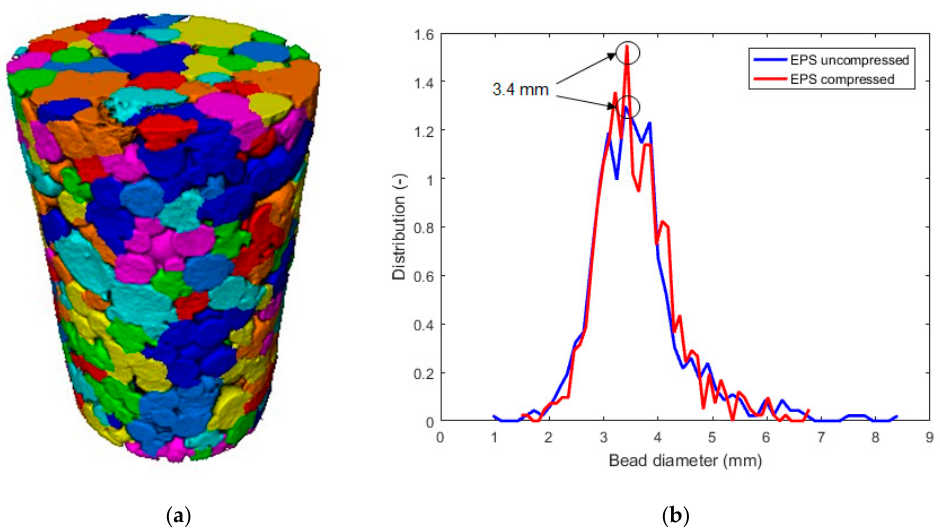
Figure 8. ( a ) Individualization of the different EPS beads, visualized by artificial color code in the compressed sample, and ( b ) bead size distribution for uncompressed and compressed EPS. Materials 2019 , 12 , x FOR PEER REVIEW